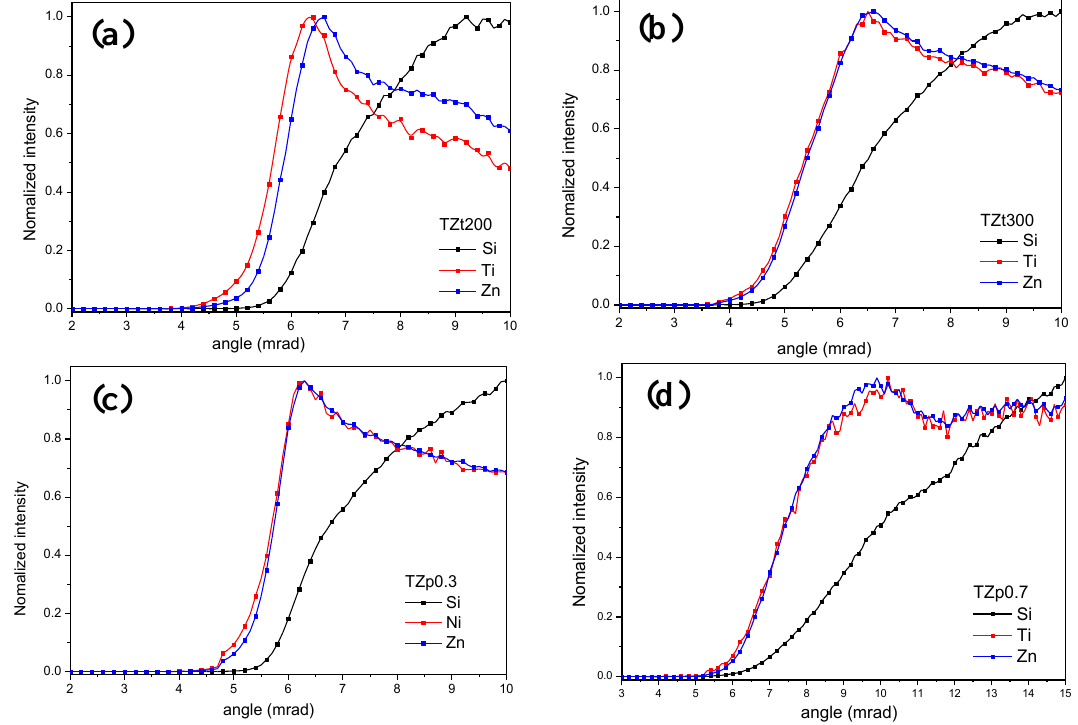
Figure 4. Grazing incidence X-ray fluorescence (GI-XRF) diagrams for Ti, Zn and Si from Ti-doped ZnO thin films with different annealing conditions. ( a ) TA at 200 ℃ , ( b ) TA at 300 ℃ , ( c ) MwPA at 0.3 mbar and ( d ) MwPA at 0.7 mbar.